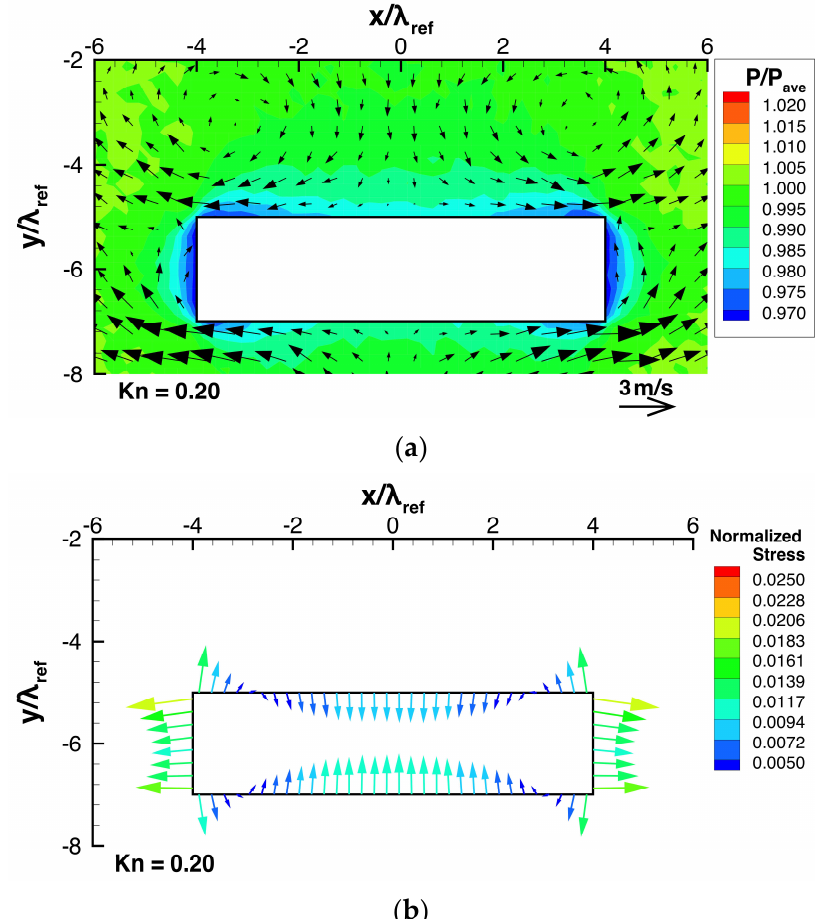
Figure 4. ( a ) Pressure and flow distributions around the beam and ( b ) stress distributions on the beam surfaces, when the beam is placed close to a heated flat substrate, at Kn = 0.2. The same is true for the low-pressure area on the top surface of the beam. The low- pressure region on the top surface of the beam sucks in gas from the narrow region of the gas above the beam. Thus, the downward-pressure-driven flow from the narrow region to the beam is induced. However, this downward flow to the top surface of the beam is much weaker than the upward flow to the bottom surface of the beam. The reason for the weaker downward flow is because the low-pressure area on the top surface can gather only a fewer number of molecules because of a smaller space between the beam and the upper substrate compared with the low-pressure area on the bottom surface. The decrease in the number of molecules near the bottom surface is more efficiently compensated by the strong upward molecular flow than that near the top surface. This causes relatively high pressure on the bottom surface compared with that on the top surface, as shown in Figures 3b and 4a.